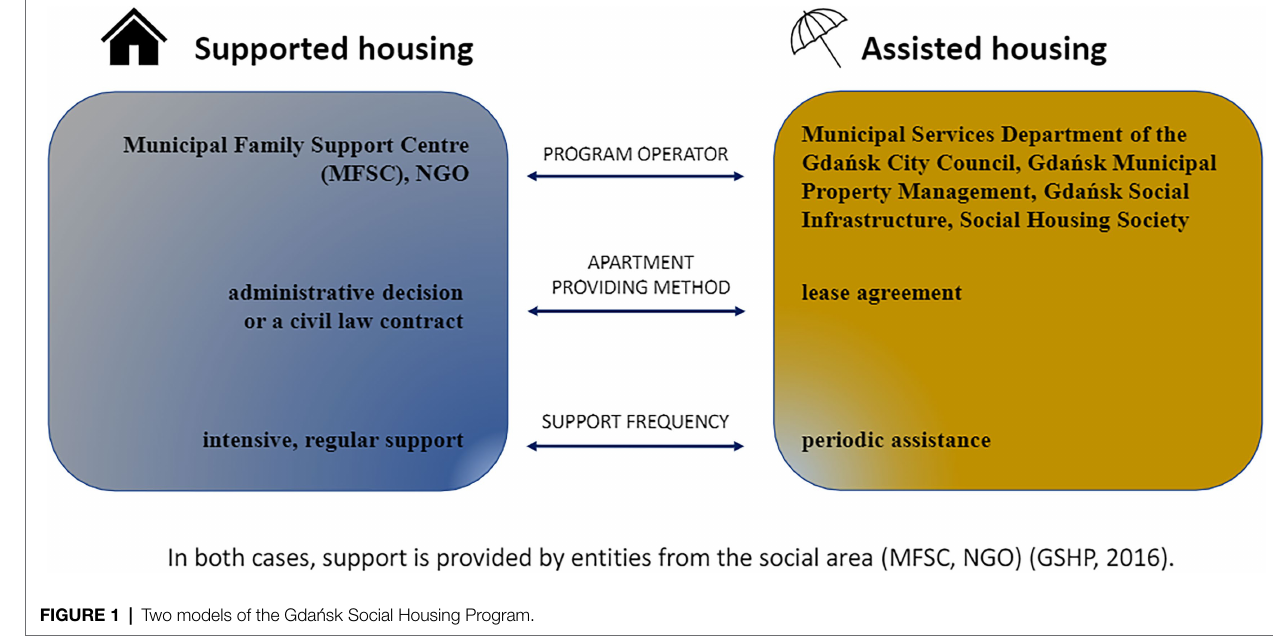
FIGURE 1 | Two models of the Gdan ́ sk Social Housing Program.